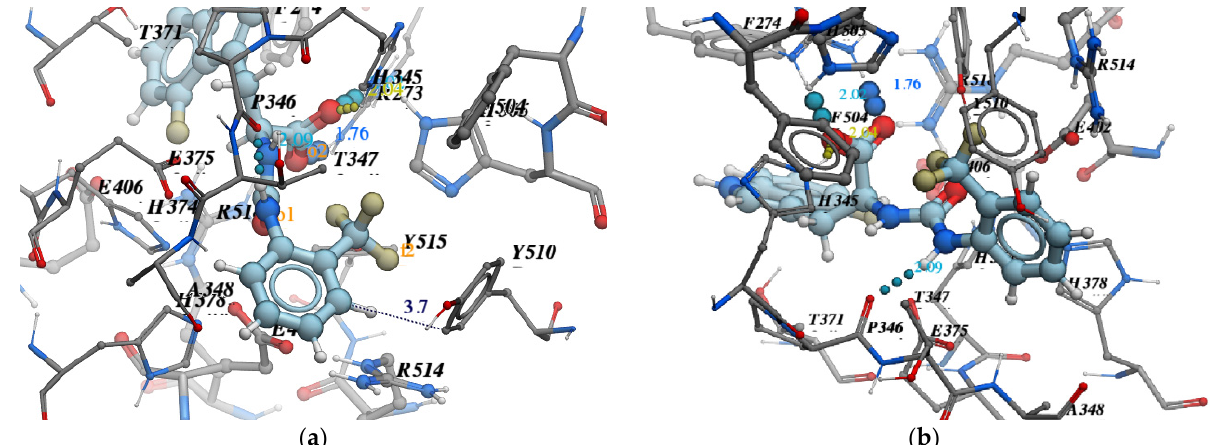
Figure 7. Important selection criteria for “cherry-picking”: ( a ) the position of the ligand’s hydrophobic moiety near TYR510; ( b ) the presence of hydrogen bond with PRO346.